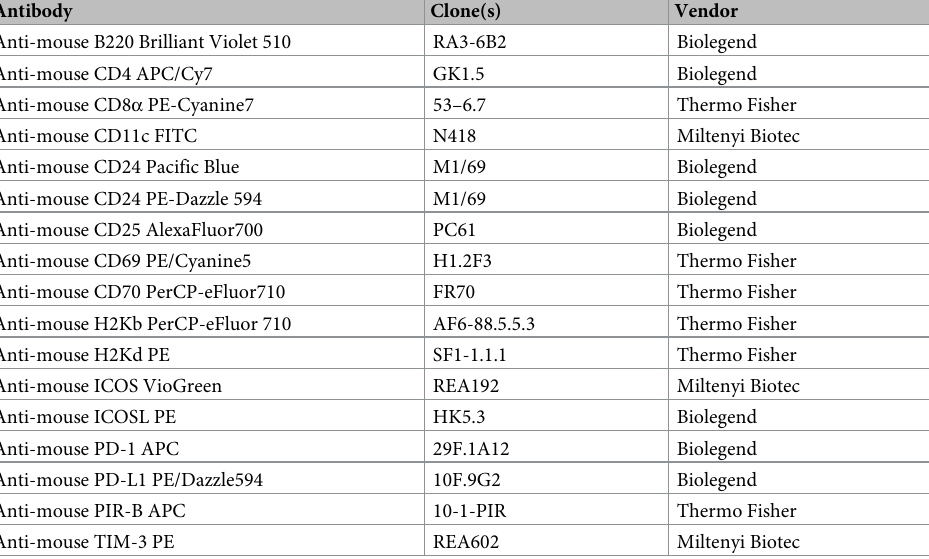
Table 1. Antibodies used for flow